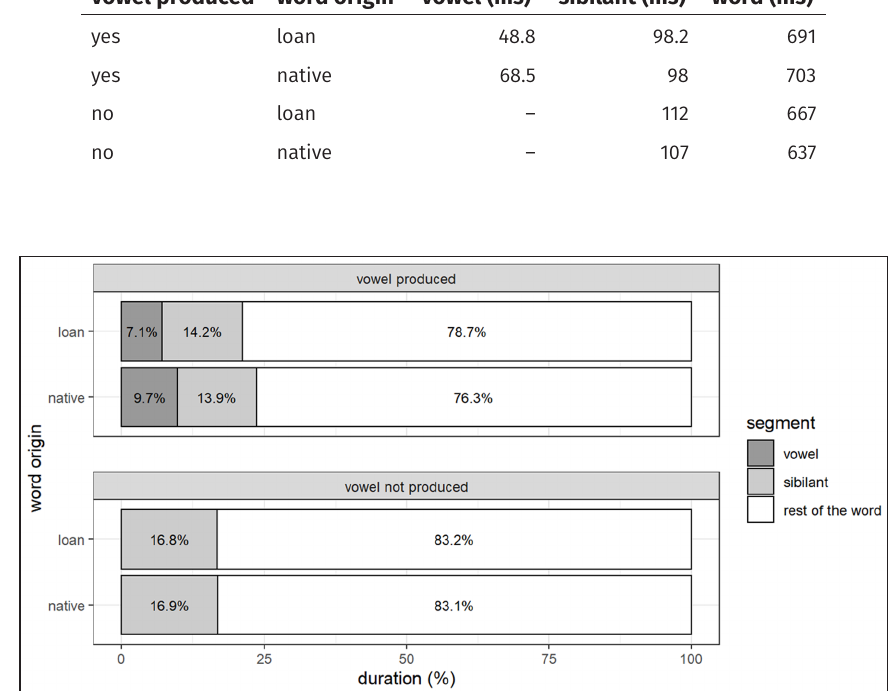
Figure 2: Relative duration by vowel occurrence for native/loan